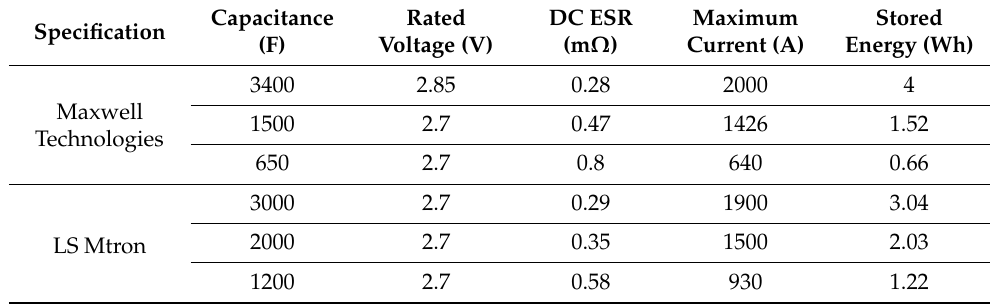
Table 3. A comparison of single-cell SCs for fast energy delivery applications